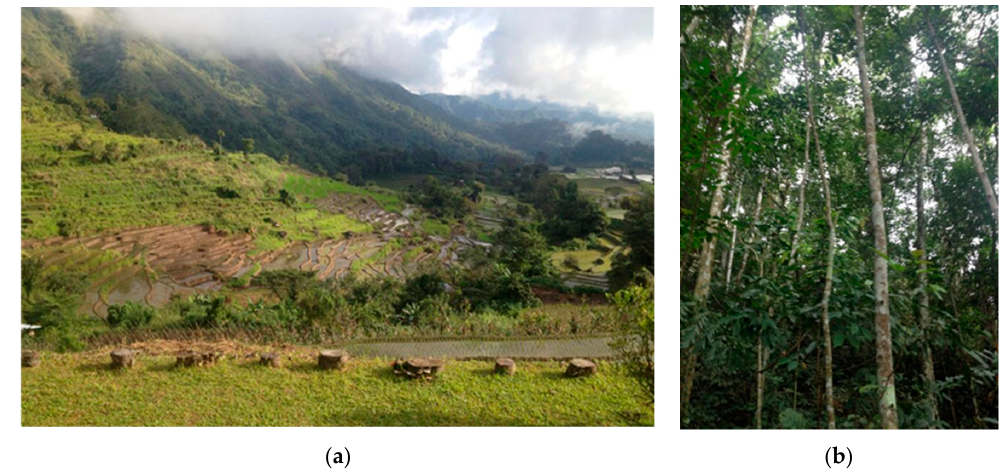
Figure 2. A typical landscape view of Ifugao rice terraces ( a ) and muyong forest ( b ).